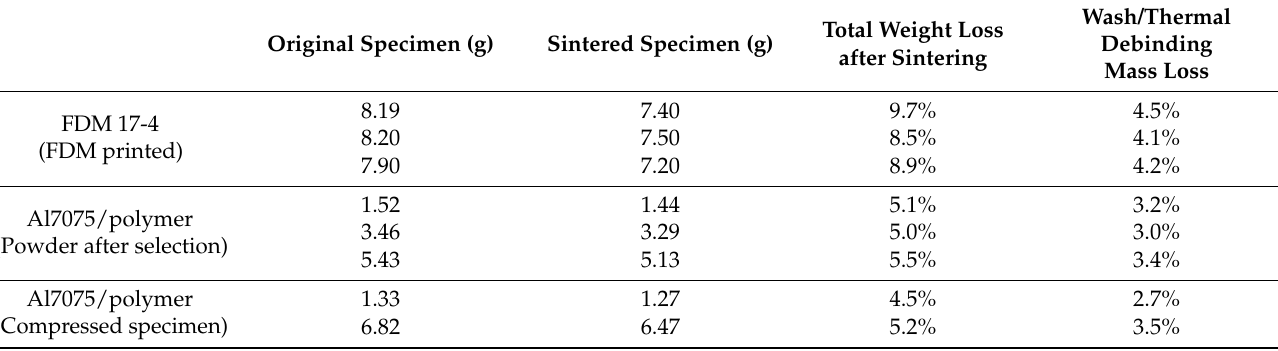
Table 2. Weight loss after debinding and